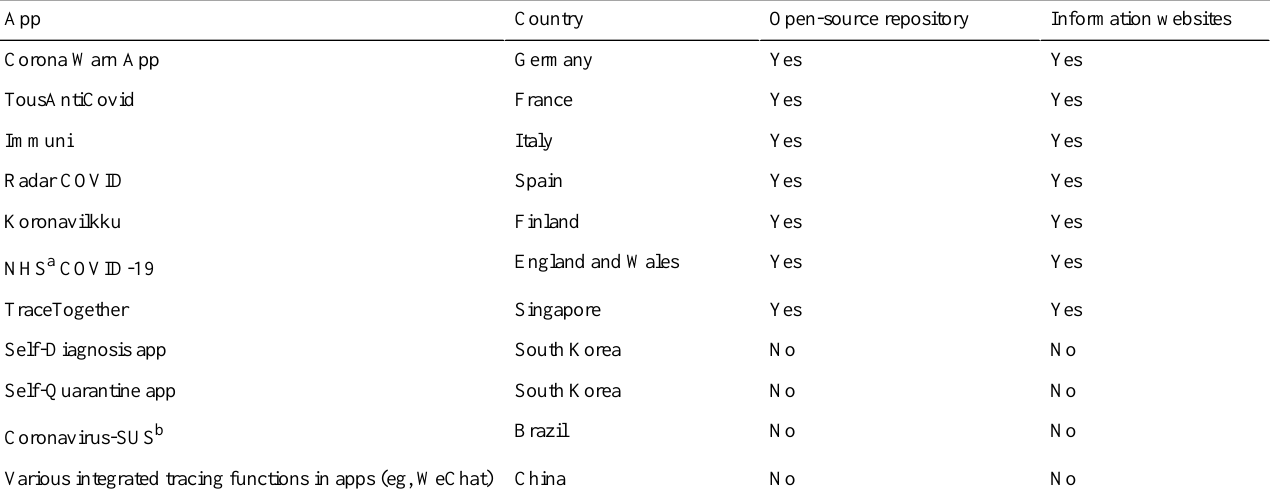
Table 1. Background information provided by the issuers of the apps.